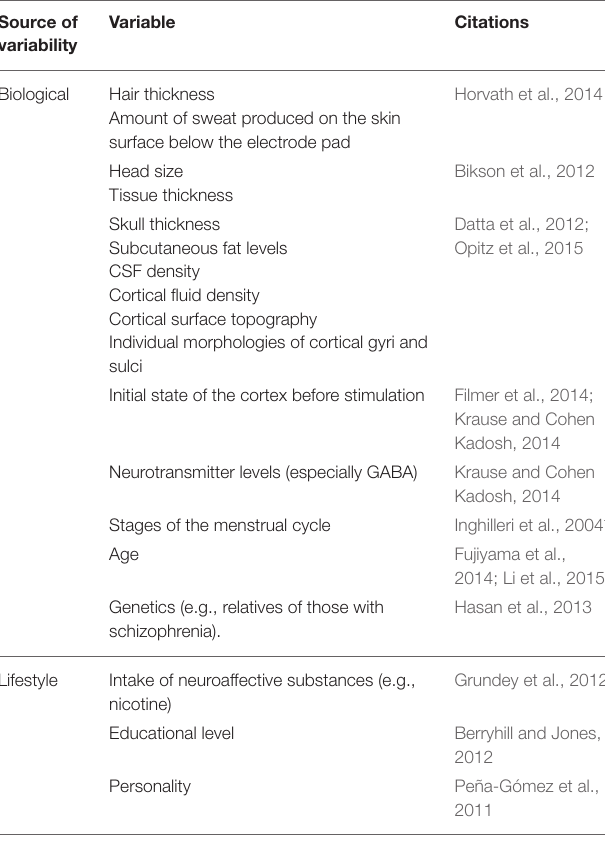
TABLE 1 | Details of variables which can alter current flow and